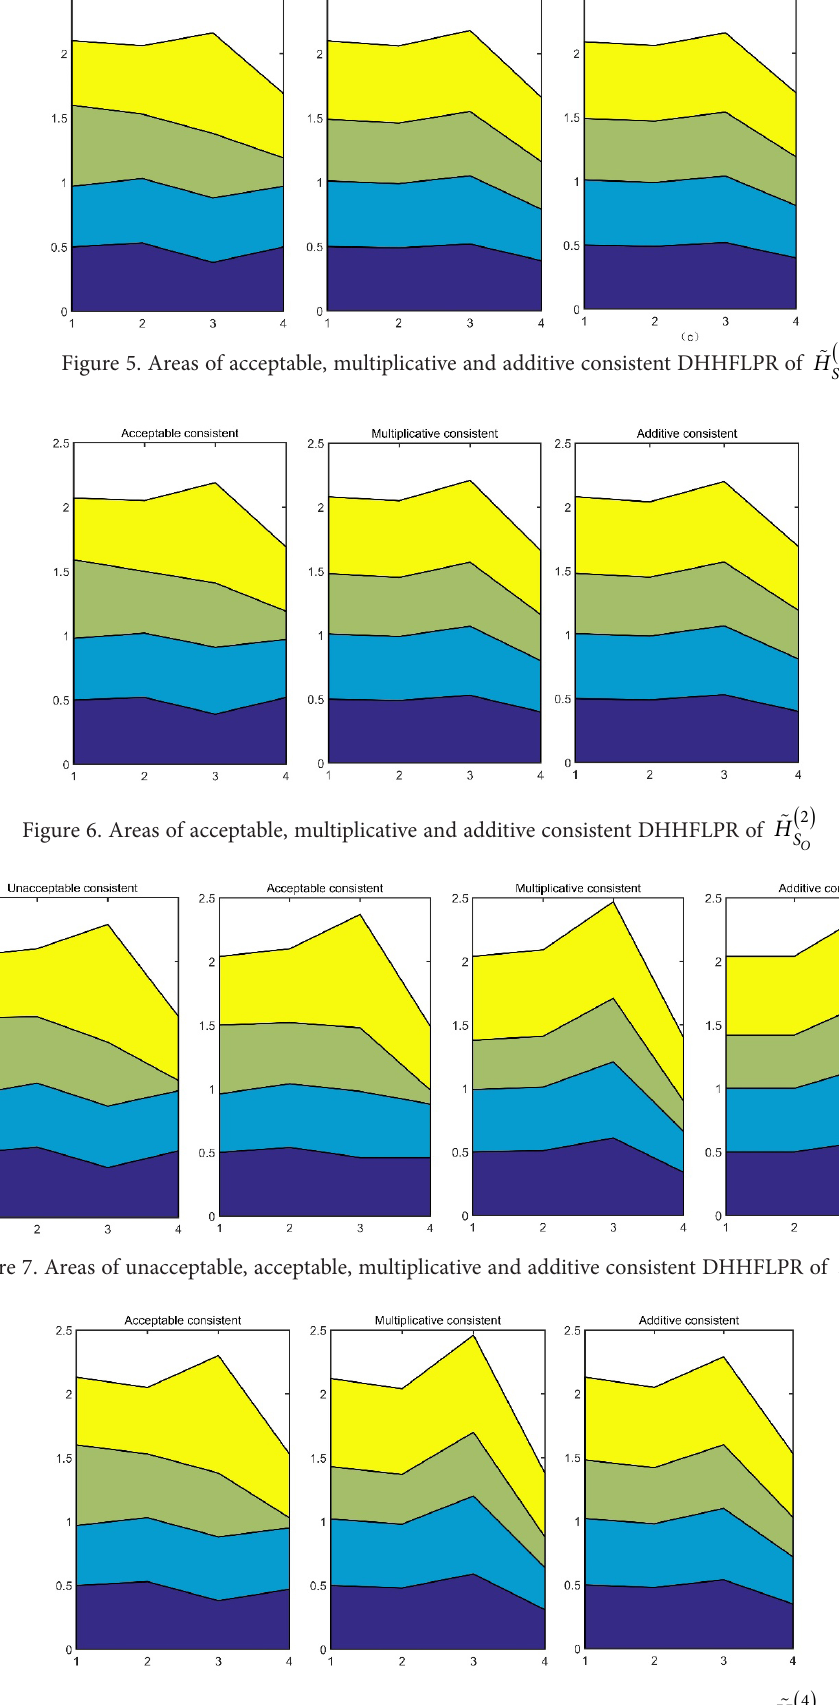
Figure 8. Areas of acceptable, multiplicative and additive consistent DHHFLPR